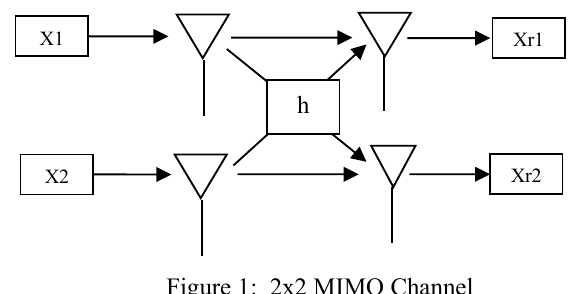
Figure 1: 2x2 MIMO